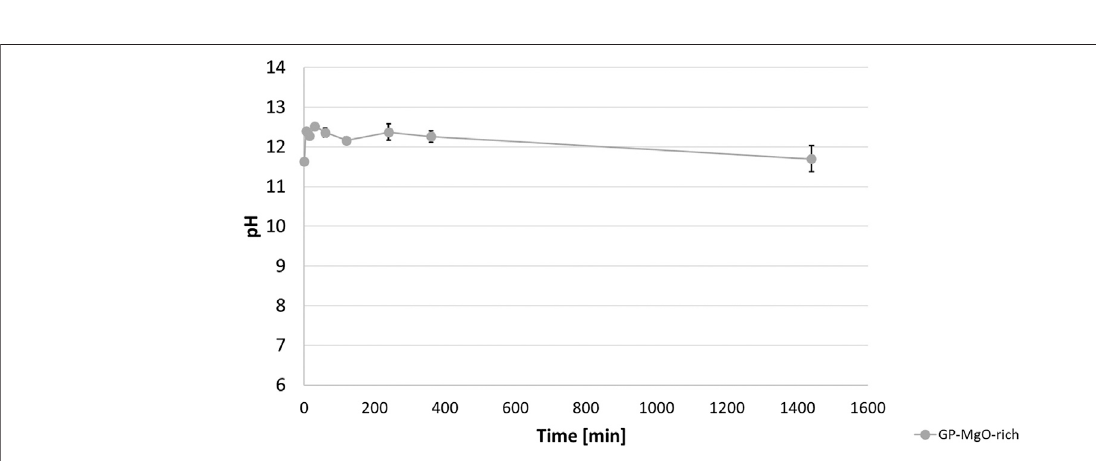
Frontiers in Materials |